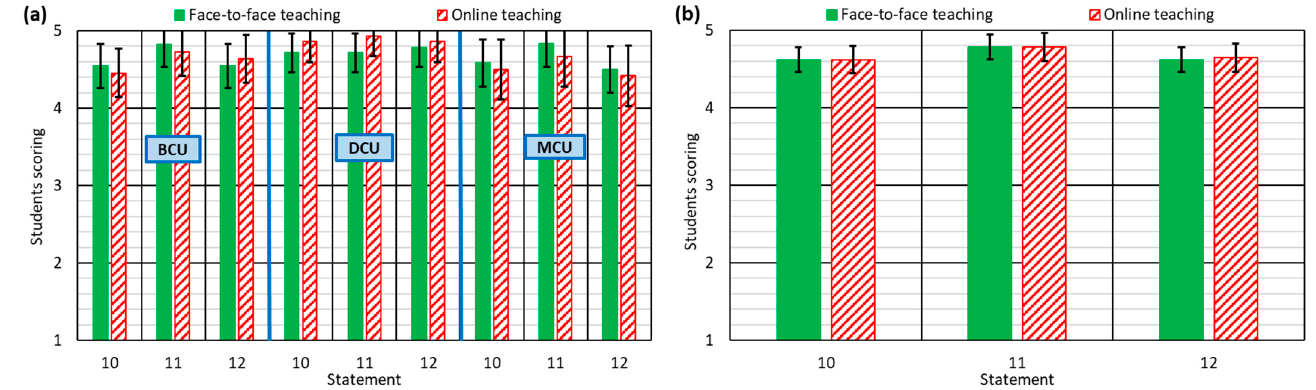
Figure 4. Student responses to statements 10–12: ( a ) for each type of course unit; ( b ) for all course units.